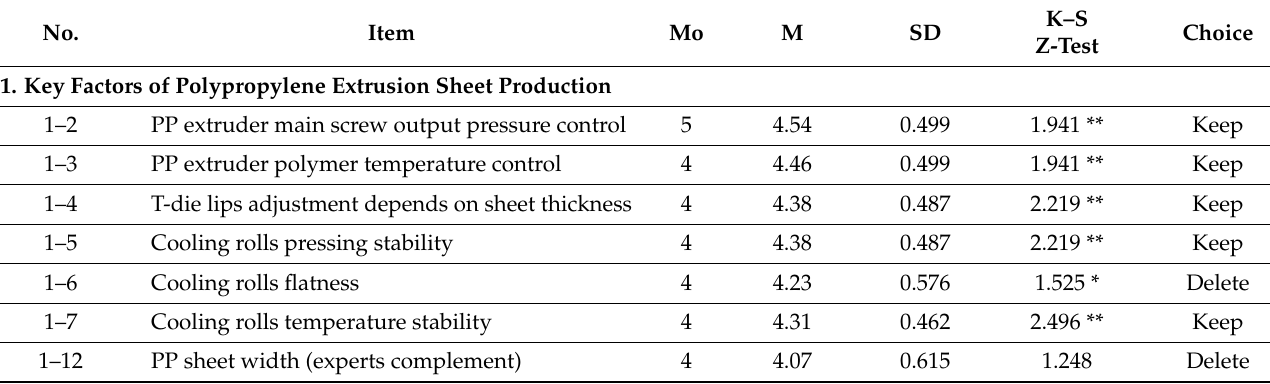
Table 6. Statistical analysis of the third Delphi